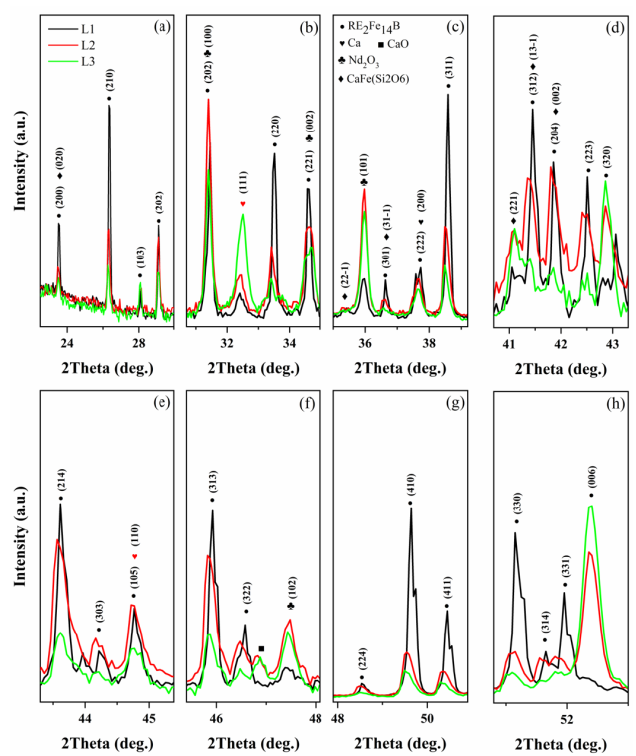
Figure 4. XRD patterns of the hot-deformed magnet with different glass fiber additions: ( a ) 2 wt.% (indexed as L1), ( b ) 5 wt.% (indexed as L2), and ( c ) 10 wt.% (indexed as L3). ( a – h ) are different main peak areas of XRD, and the height of the peaks was scaled to the same height.